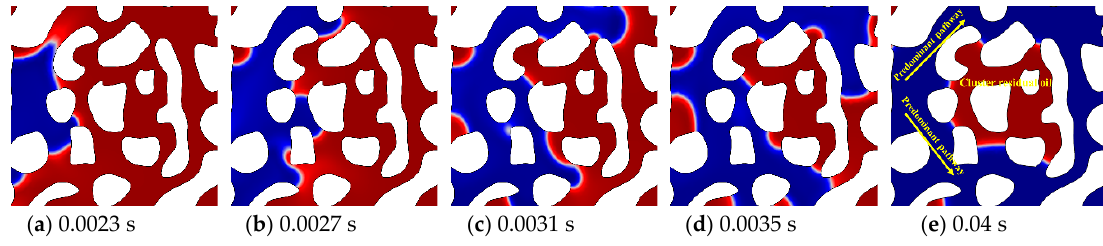
Figure 6. The formation process of cluster residual oil.